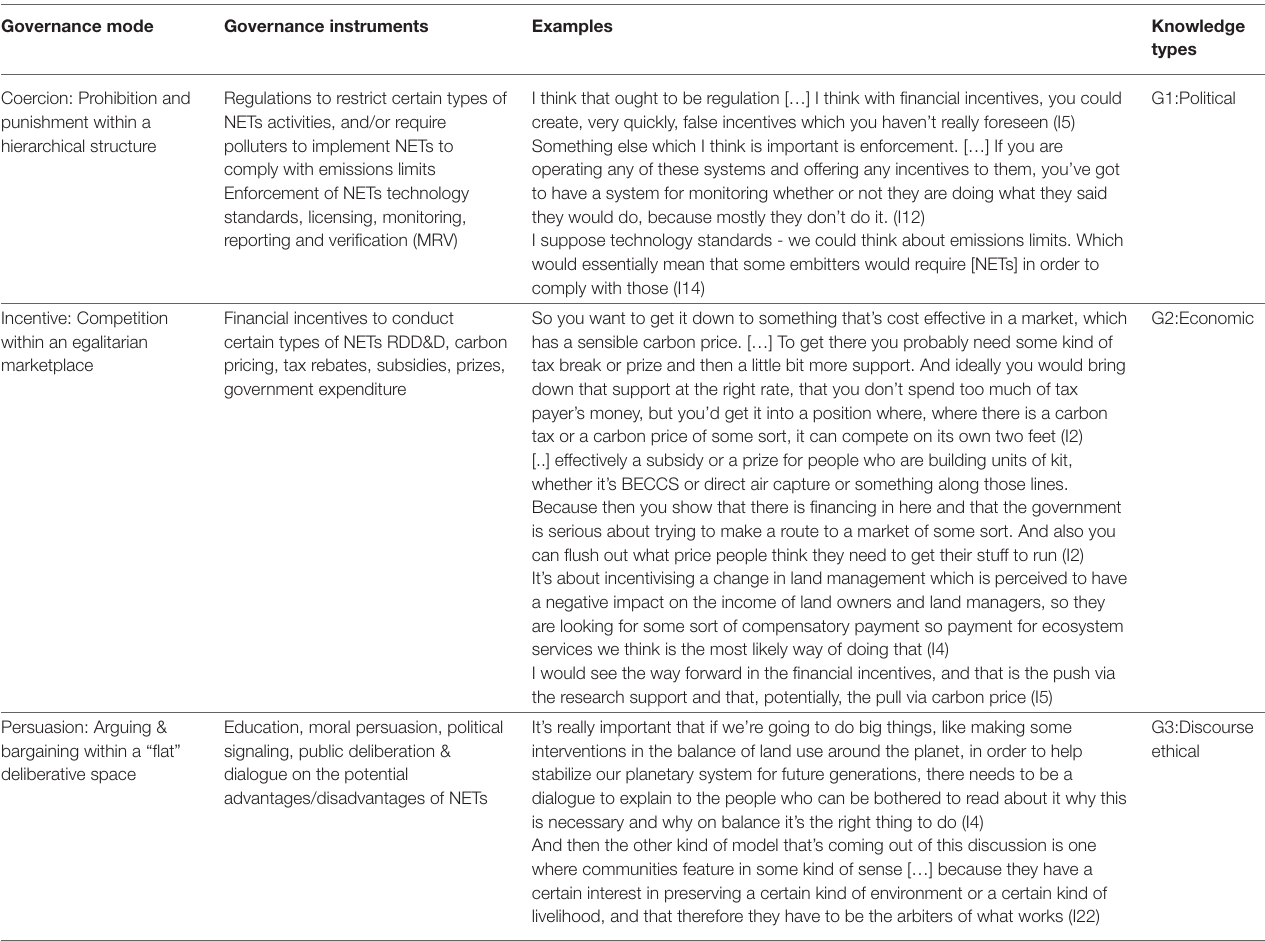
TABLE 6 | Governance modes and instruments shaped by discusive